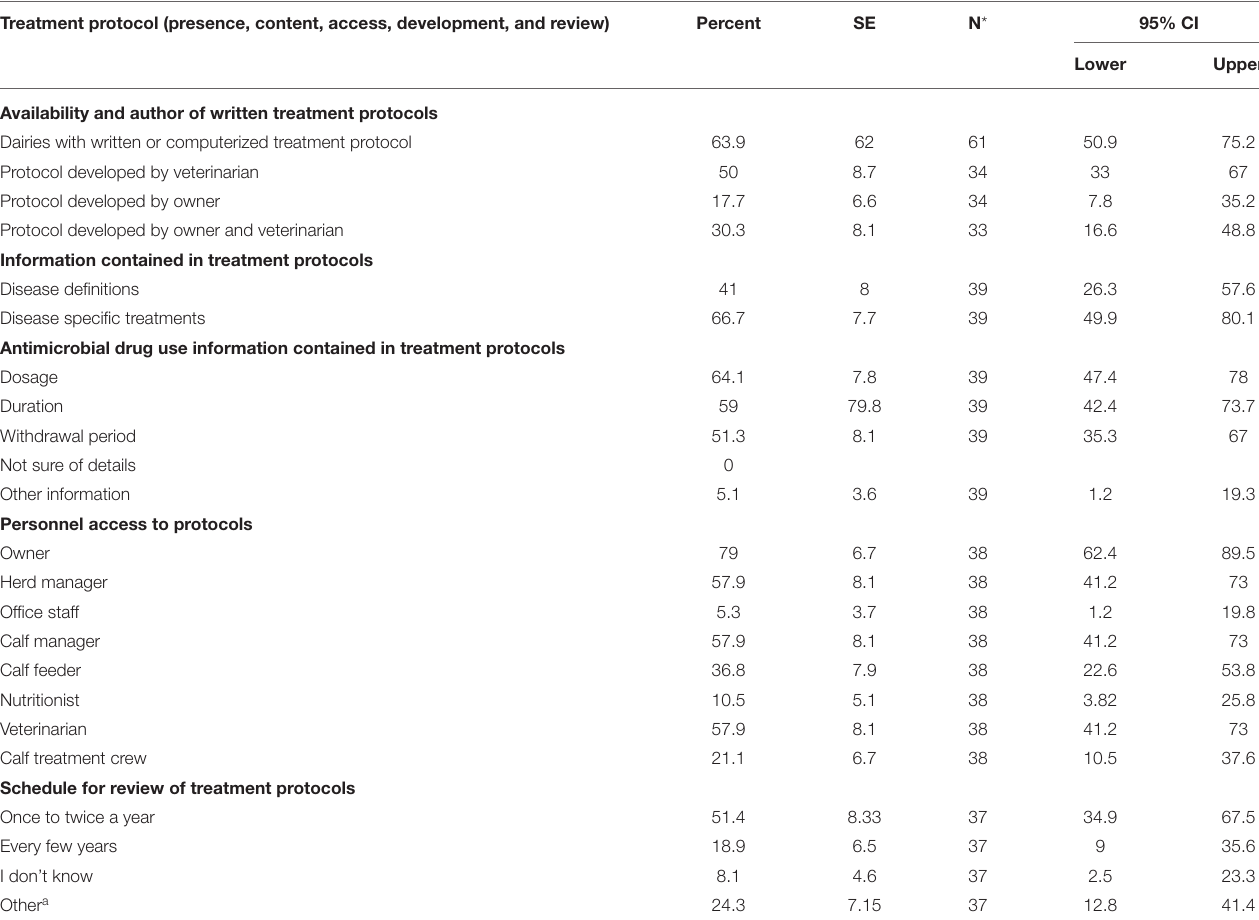
TABLE 4 | Use of treatment protocols for health management in preweaned calves on California dairies. Treatment protocol (presence, content, access, development, and review) Percent